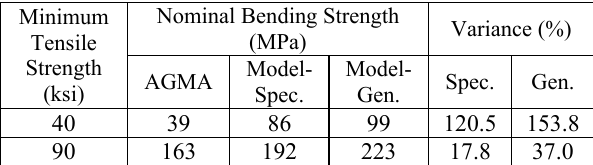
Table 5: Nominal Bending Strength Estimate Comparison for Bronze